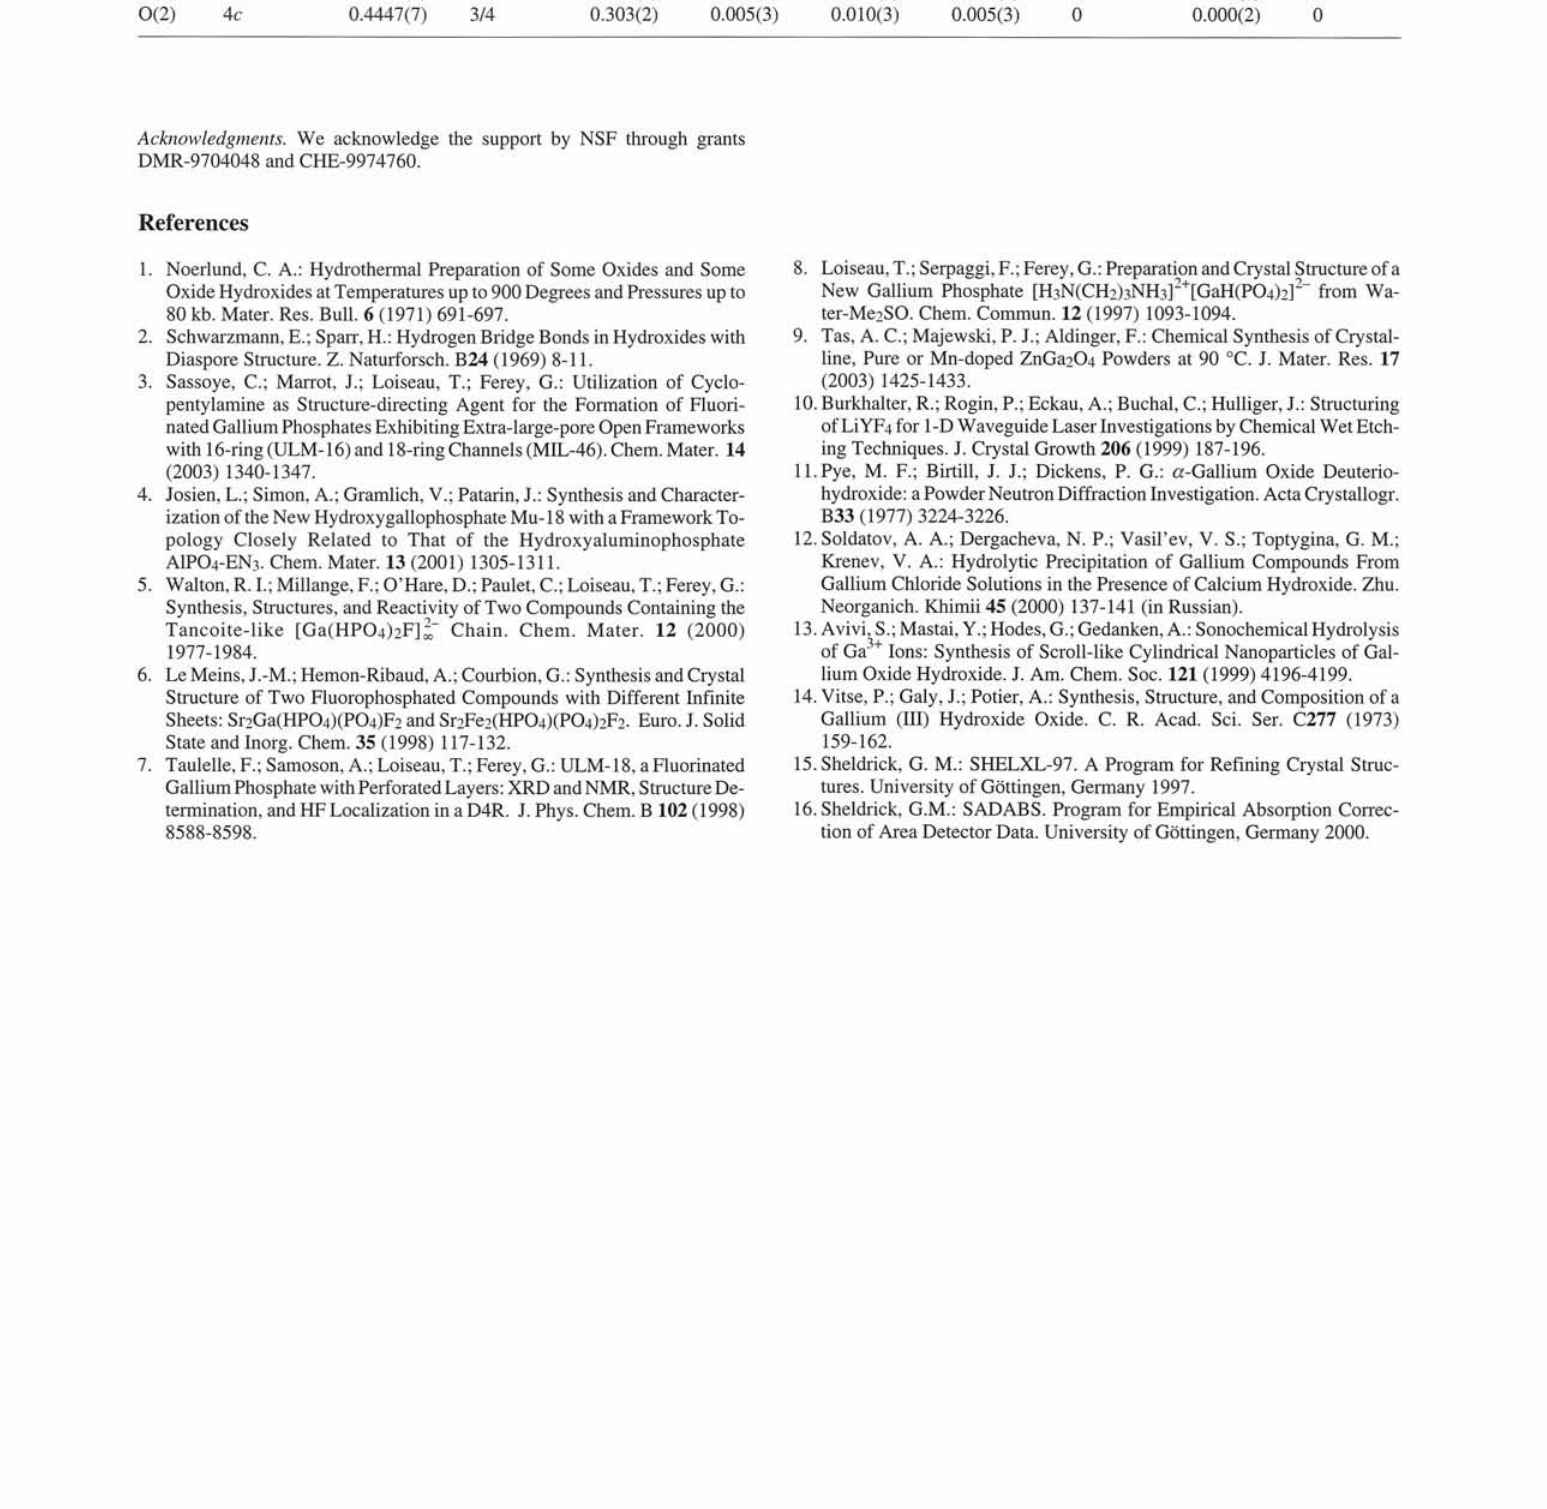
Table 3. Atomic coordinates and displacement parameters (in